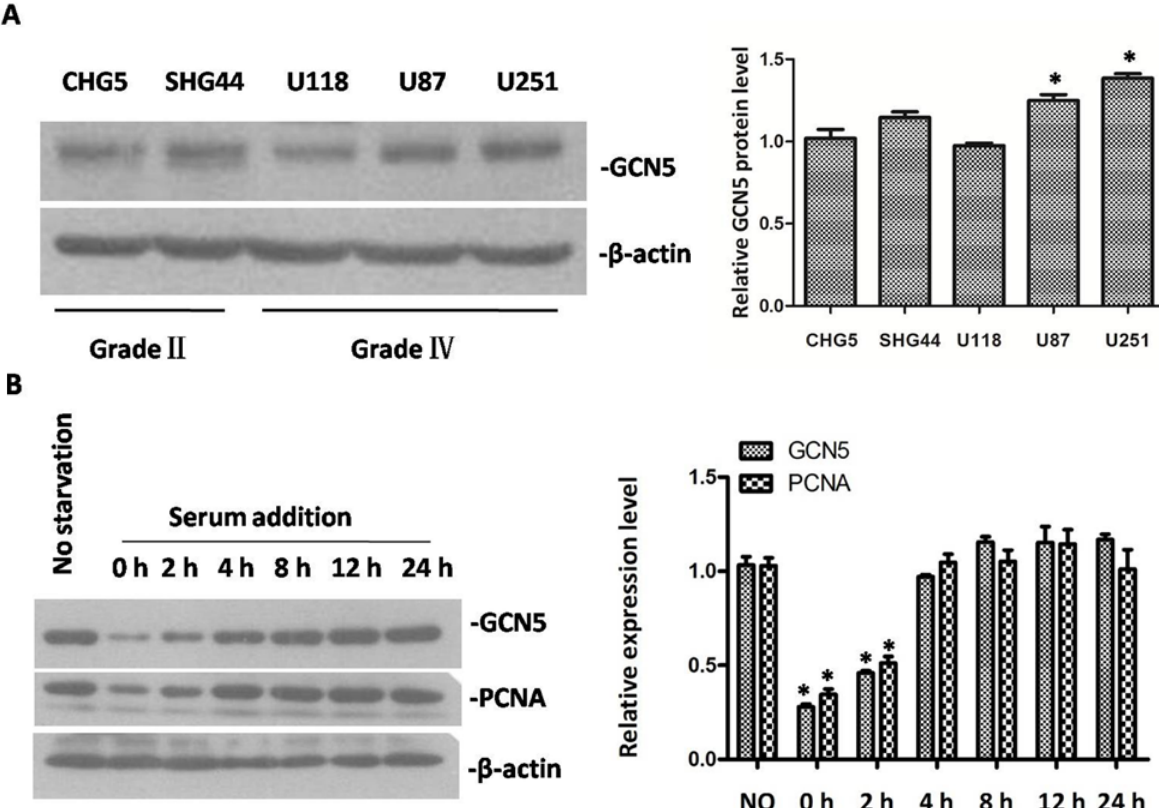
Figure 2. GCN5 expression in glioma cell lines and cell cycle progression. ( A ) The expression of GCN5 in five glioma cell lines was determined by Western blot; and ( B ) GCN5 and PCNA expression pattern in serum starvation and releasing model experiment (* p < 0.05, compared with NO